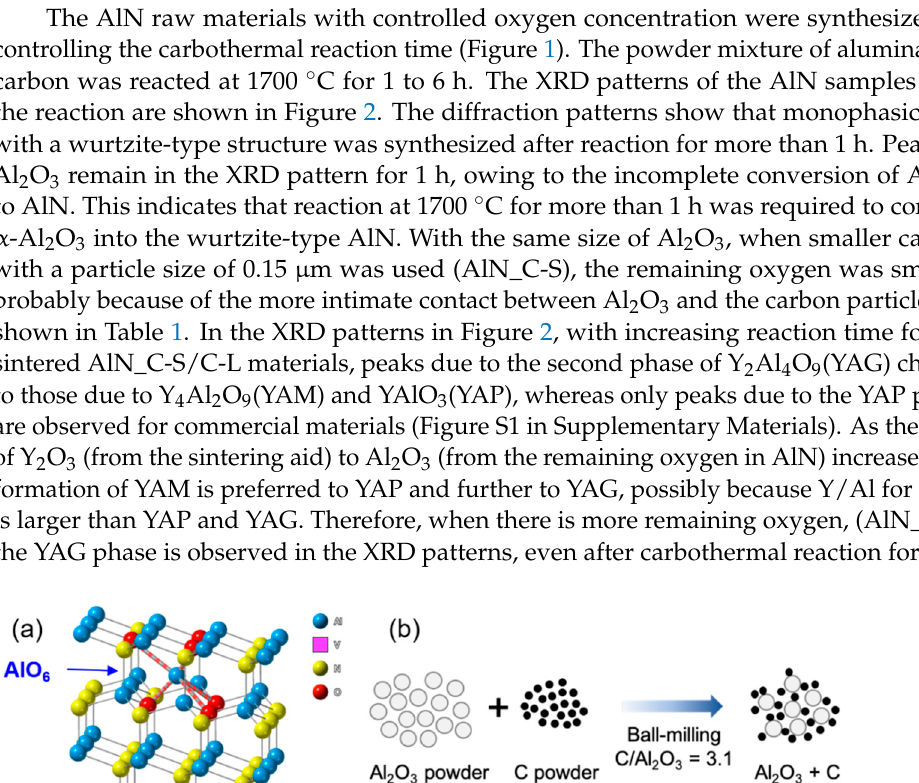
Figure 2. XRD patterns for ( a ) raw materials (AlN_C-S, AlN_C-L), ( b ) sintered AlN_C-S samples, and ( c ) sintered AlN_C-L samples. As carbothermal reaction exceeds 1 h, peaks due to aluminum